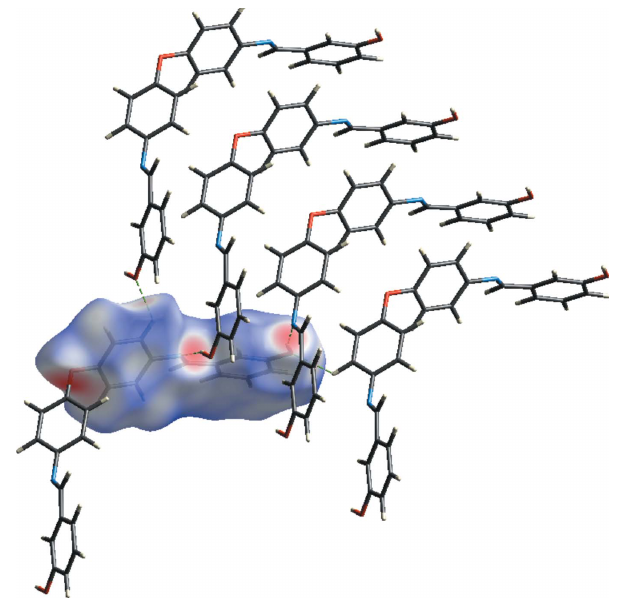
Figure 4 Aview of the three-dimensional Hirshfeld surface for the title compound, plotted over d norm in the range (cid:5) 1.1242 to 1.4437